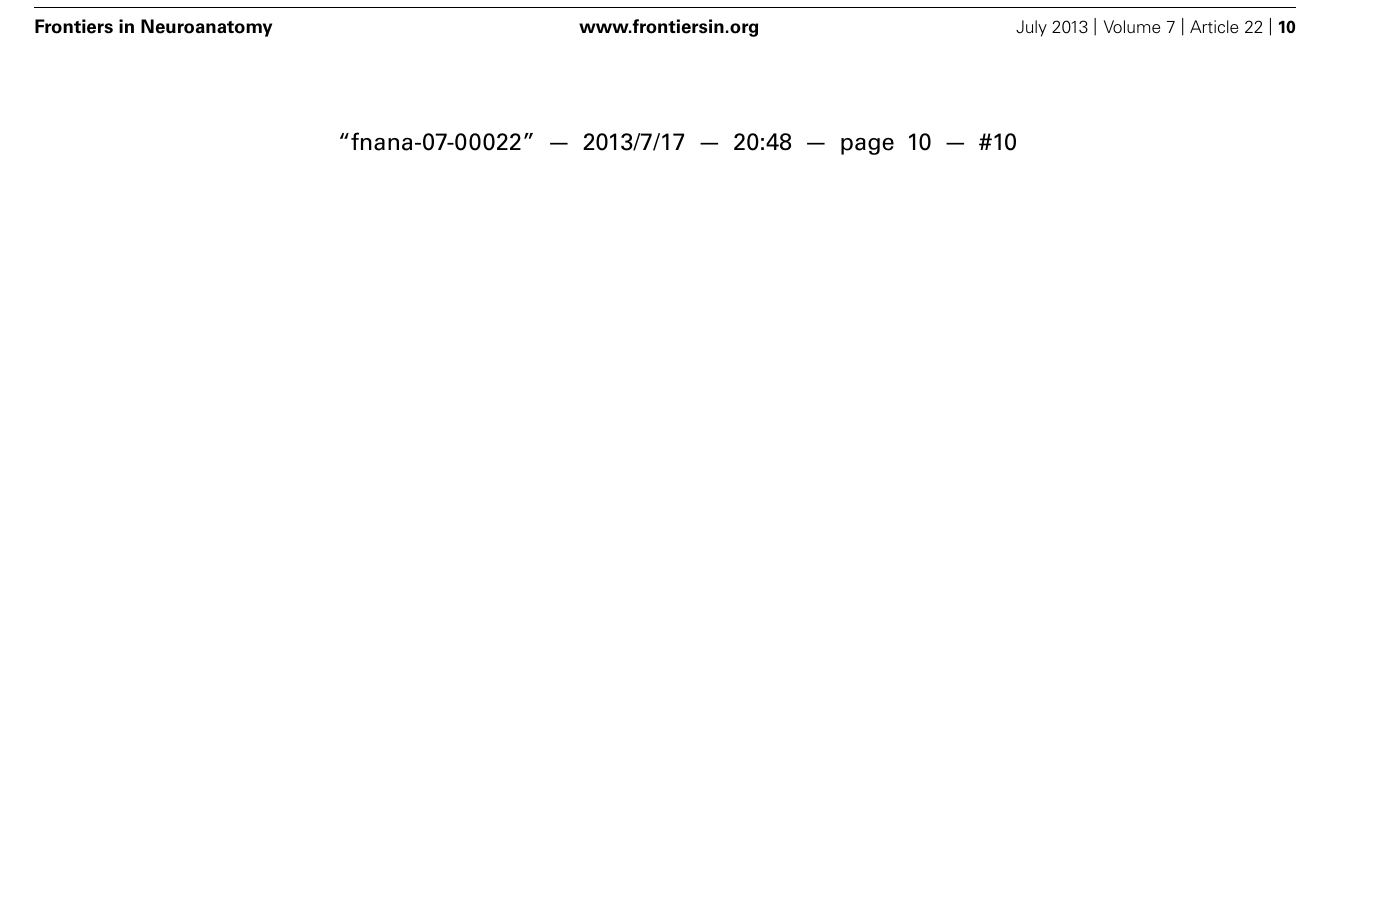
were imported into Cytoscape 2.8.2.The human placenta–brain network was constructed using a JGraph circle layout. Using NetworkAnalyzer, the interactions across nodes were visualized in red lines, and the thickness of the edges was weighted using the STRING’s score (Ss), which indicates the level of interaction between